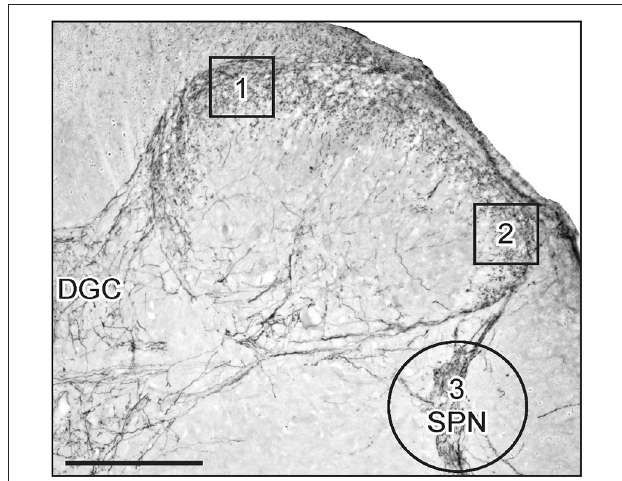
FIGURE 1 | Areas of interest (AOIs) used for densitometric image analysis following visceral nerve transection . Image shows a micrograph of CGRP-immunoreactivity (IR) in the superficial dorsal horn and sacral parasympathetic nucleus (SPN) within sacral spinal cord. AOIs 1 and 2 (130 × 130 µ m) were aligned with the medial and lateral margins of the superficial dorsal horn (boxes 1 and 2, respectively). Both AOIs were assessed for GFR α 1, GFR α 2, GFR α 3 and CGRP in the lumbar and sacral spinal cord. The AOI encompassing the SPN (circle 3, diameter 250 µ m) was assessed for GFR α 1, GFR α 3 and CGRP. Image also shows location of the dorsal gray commissure (DGC). Scale bar represents 200 µ